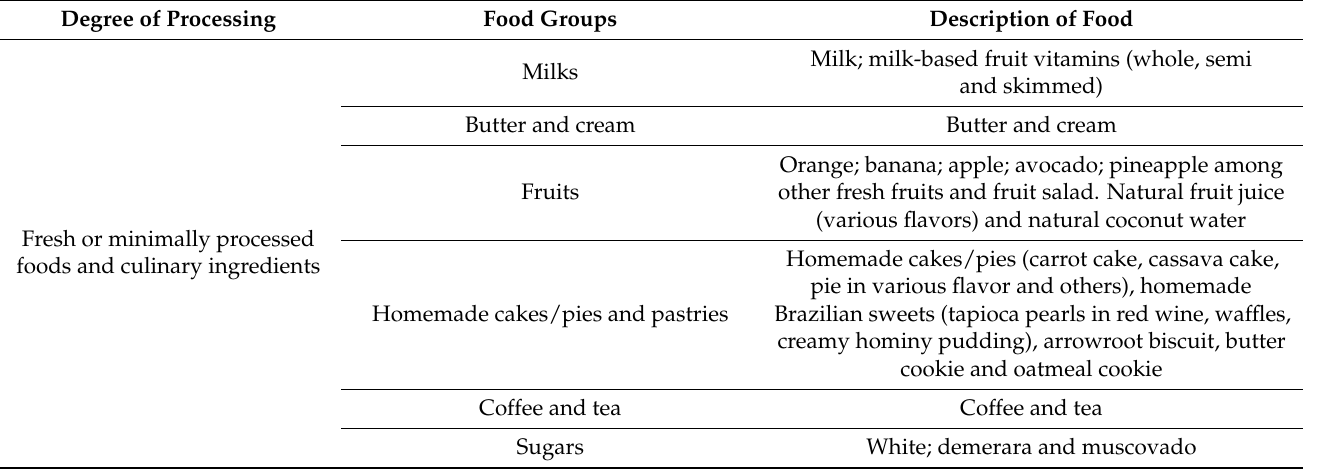
Table 1. Food groups included in the analysis of breakfast patterns in children and adolescents with CHD. Brazil